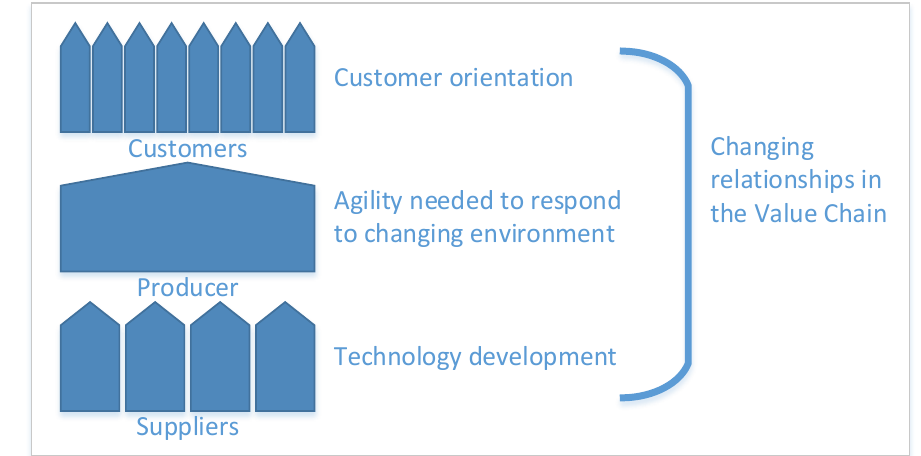
Figure 1. Changing relationships in value chains.